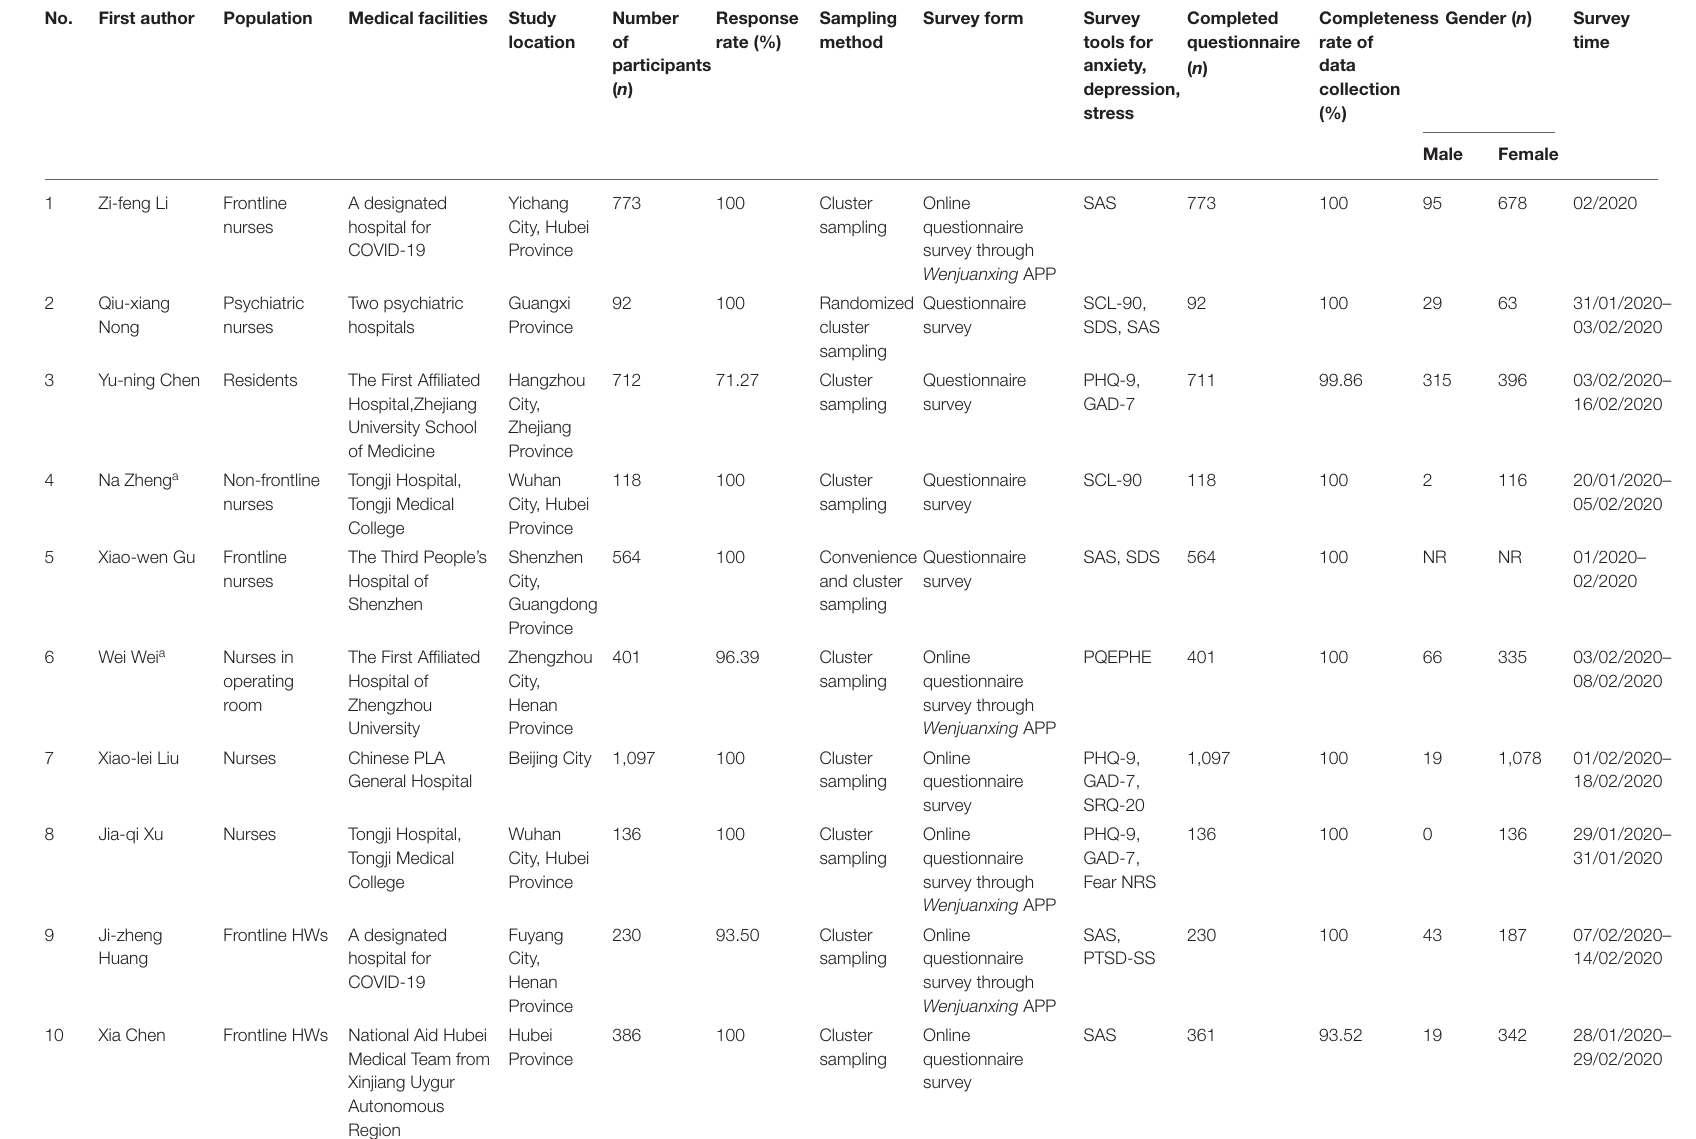
TABLE 1 | Characteristics of the included studies reporting on healthcare workers’ psychosocial status during the COVID-19 pandemic.